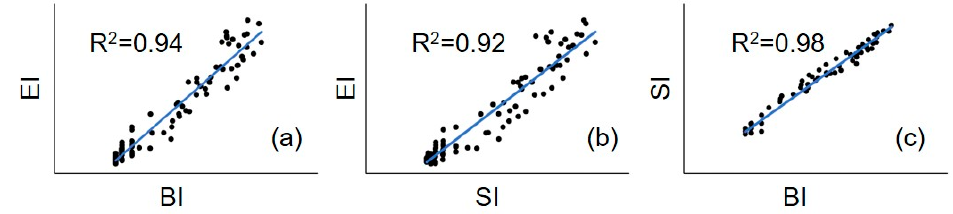
Figure 12. Correlations of the three evaluation indices (EI, BI, and SI): ( a ) EI vs. BI, ( b ) EI vs. SI, and ( c ) SI vs. BI. EI: efficiency index; BI: improved blocking index; SI: surface complexity index.